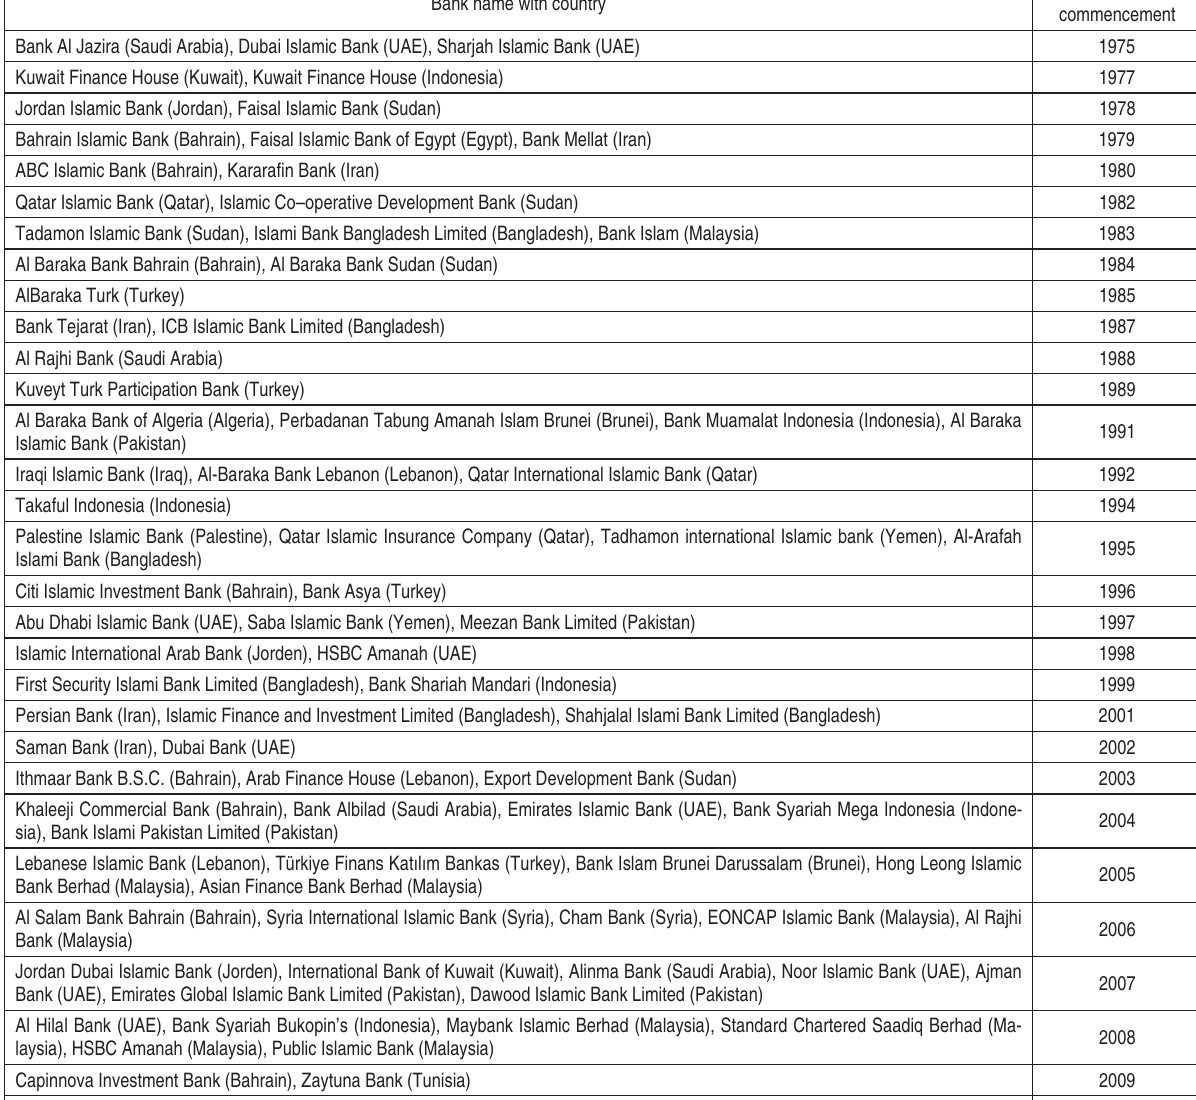
Table 1. Name of Islamic bank with the date of establishment and